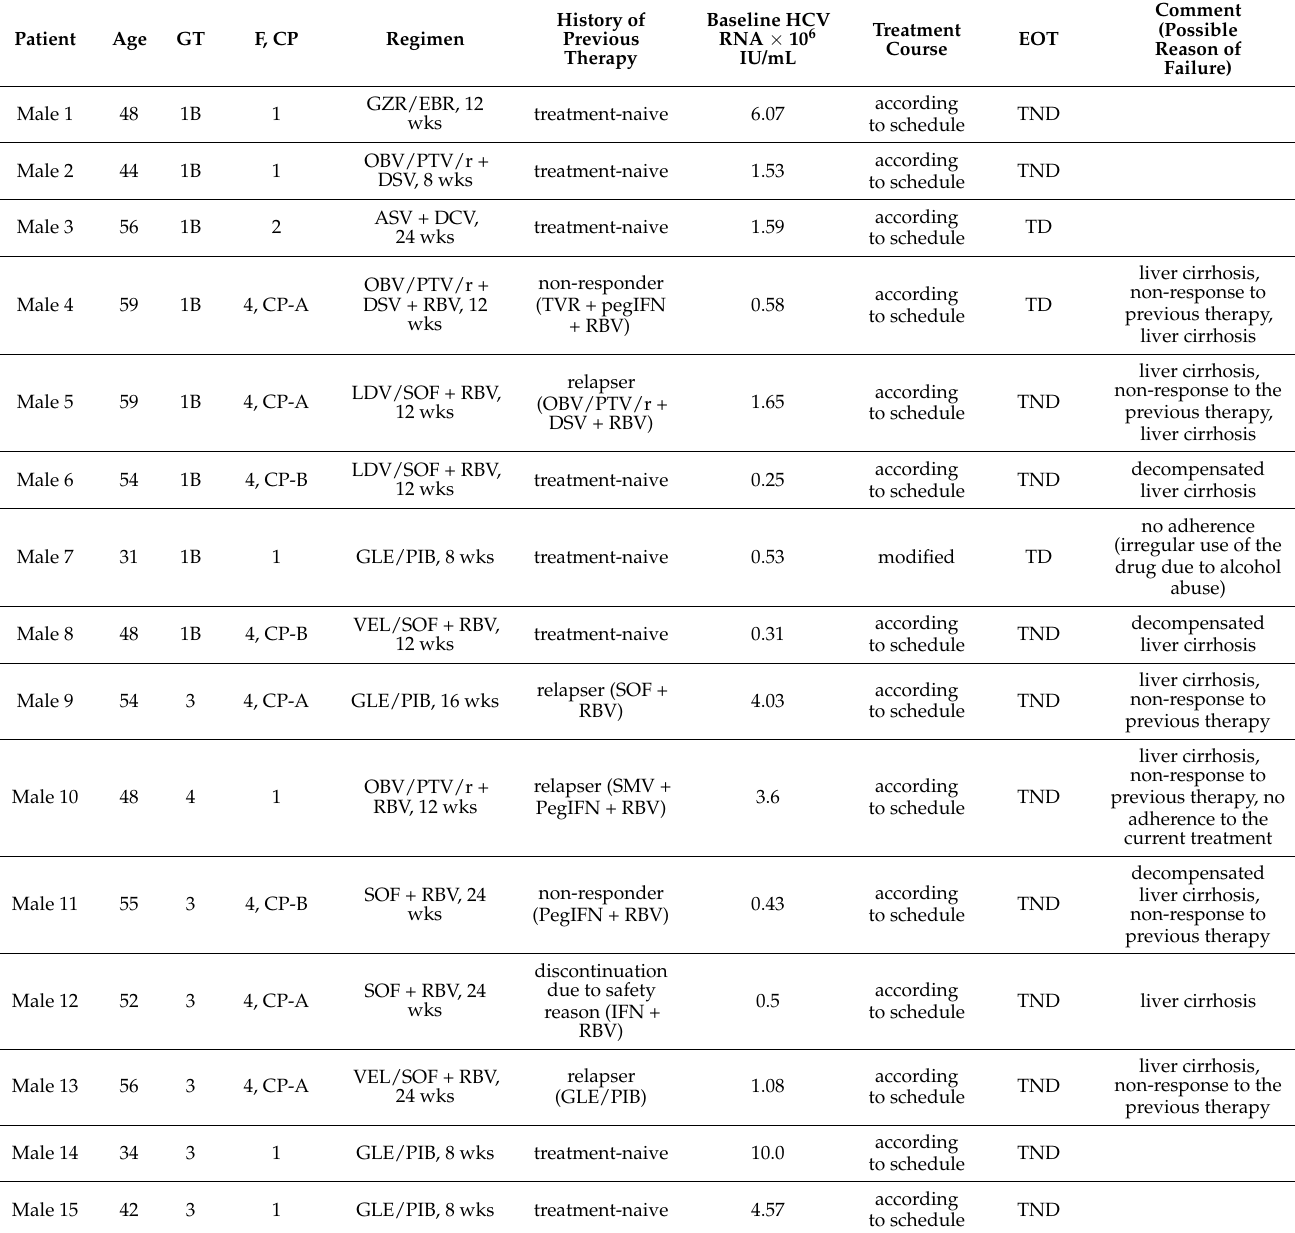
Table 7. Characteristics of 15 Virologic Failures to